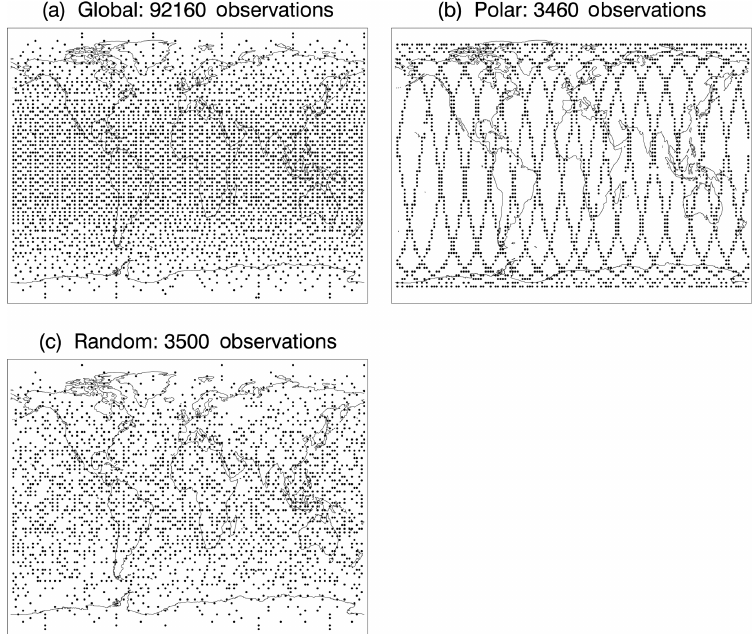
Figure 1. Locations of simulated ozone observations for (a) global, (b) polar-orbiting, and (c) random data. For global data, these represent hourly coverage, while for polar and random data these are all the observations over a 24h